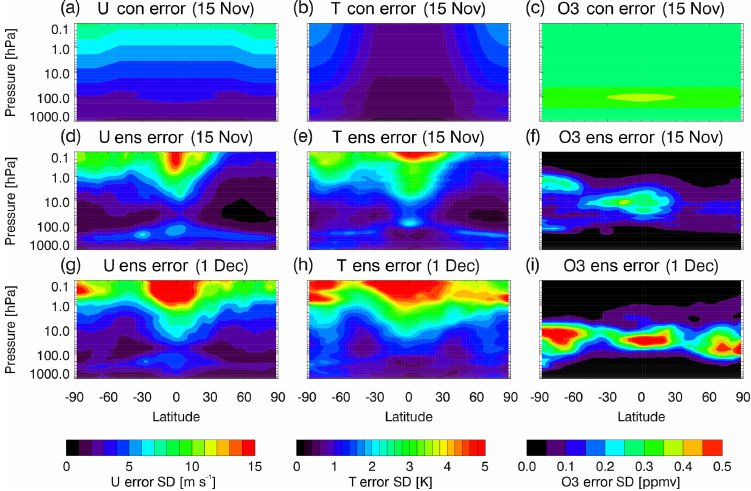
Figure 9. Conventional background error standard deviations for (a) zonal wind (ms − 1 ), (b) temperature (K), and (c) ozone (ppmv) for 15 November 2014 (00:00Z). Ensemble background error standard deviations for (d) zonal wind, (e) temperature, and (f) ozone for 15 November 2014 (00:00Z). Ensemble background error standard deviations for (g) zonal wind, (h) temperature, and (i) ozone for 1 De- cember 2014 (00:00Z). Color bars are provided for zonal wind, temperature, and ozone, with red (blue) indicating high (low)